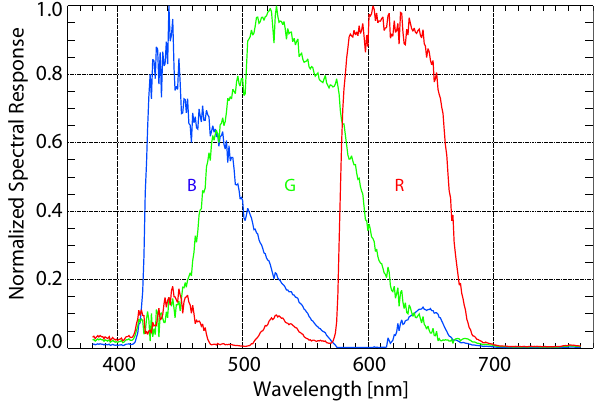
Figure 1. The relative spectral response of the Canon PowerShot G10 CCD sensor for the red, green and blue channel, investigated at the IMuK